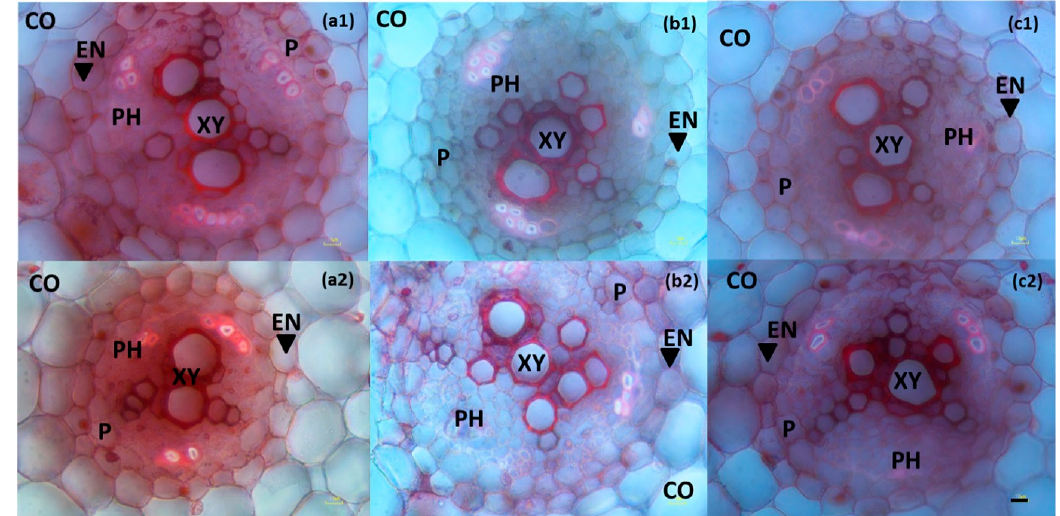
Figure 7. Freehand cross sections of second order lateral roots of peanut under well-irrigated conditions ( a1 , b1 and c1 ) and drought stress conditions ( a2 , b2 and c2 ) at 21, 28 and 35 DAE. CO, cortex; EN, endodermis; P, pericycle; PH, phloem; XY, xylem; Scale bar = 10 µm; 40×.